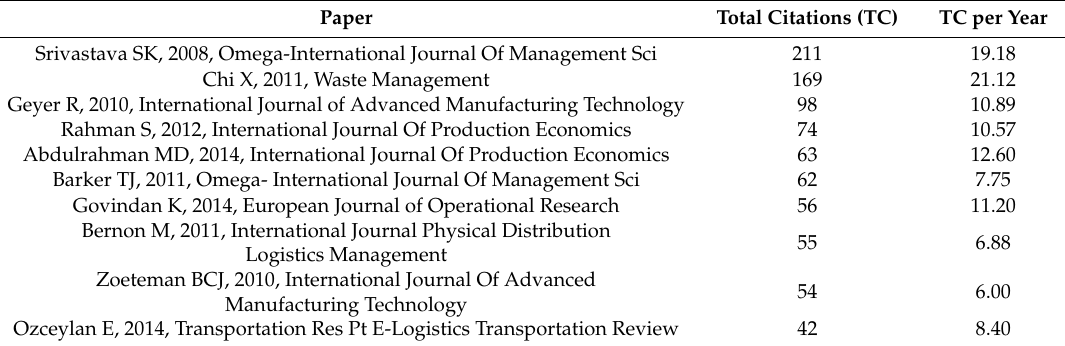
Table 2. Descriptive analysis: Top 10 top manuscripts per